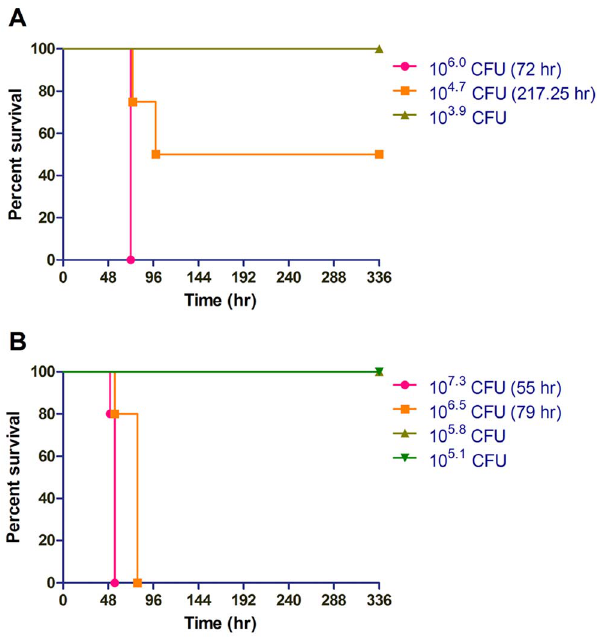
Fig. 5. Host response to capsule and T3SS3 mutants of B. pseudomallei . Groups of 5 female albino C57BL/6J mice were challenged by the IMIT route of infection with increasing doses of either D wcb capsule mutant (A) or D sctU Bp3 T3SS3 mutant (B) in the luminescent B. pseudomallei strain JW280 background. Mice were monitored for 14 days (336 hr) for disease progression and euthanized at the onset of moribund disease presentation. Survival curves are used to present the dose-dependent response of the host to increasing bacterial challenges of B. pseudomallei mutants. The MTTD was calculated for groups with $ 50% mortality, as indicated.